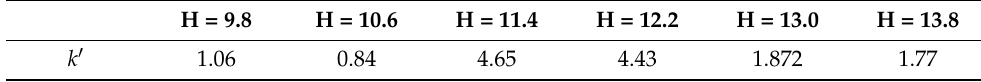
Table 3. Values of k (cid:48) under different bridge deck spacings. H =